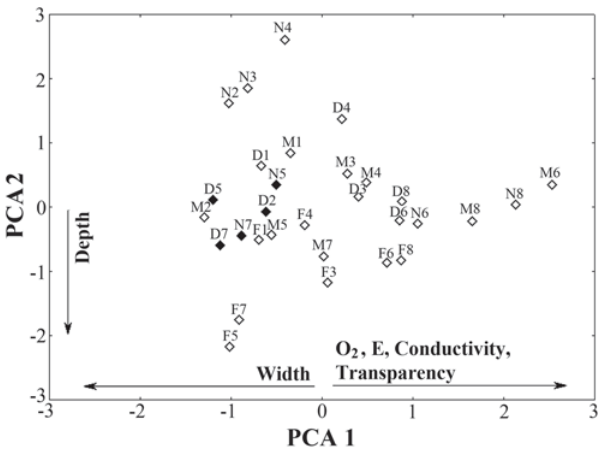
Fig. 5. Principal Components Analysis (PCA) of the matrix of environmental variables recorded in the headwaters of the Cuiabá River in November (N), December 2007 (D), January (J), February (F), and March 2008 (M). Numbers following months represent sites: 1=CBZ I, 2=CBZ II, 3=AFS, 4=CBS, 5=CBZ III, 6=TRS, 7=CBZ IV, 8=QBS. Dark symbols represent collections with highest density of